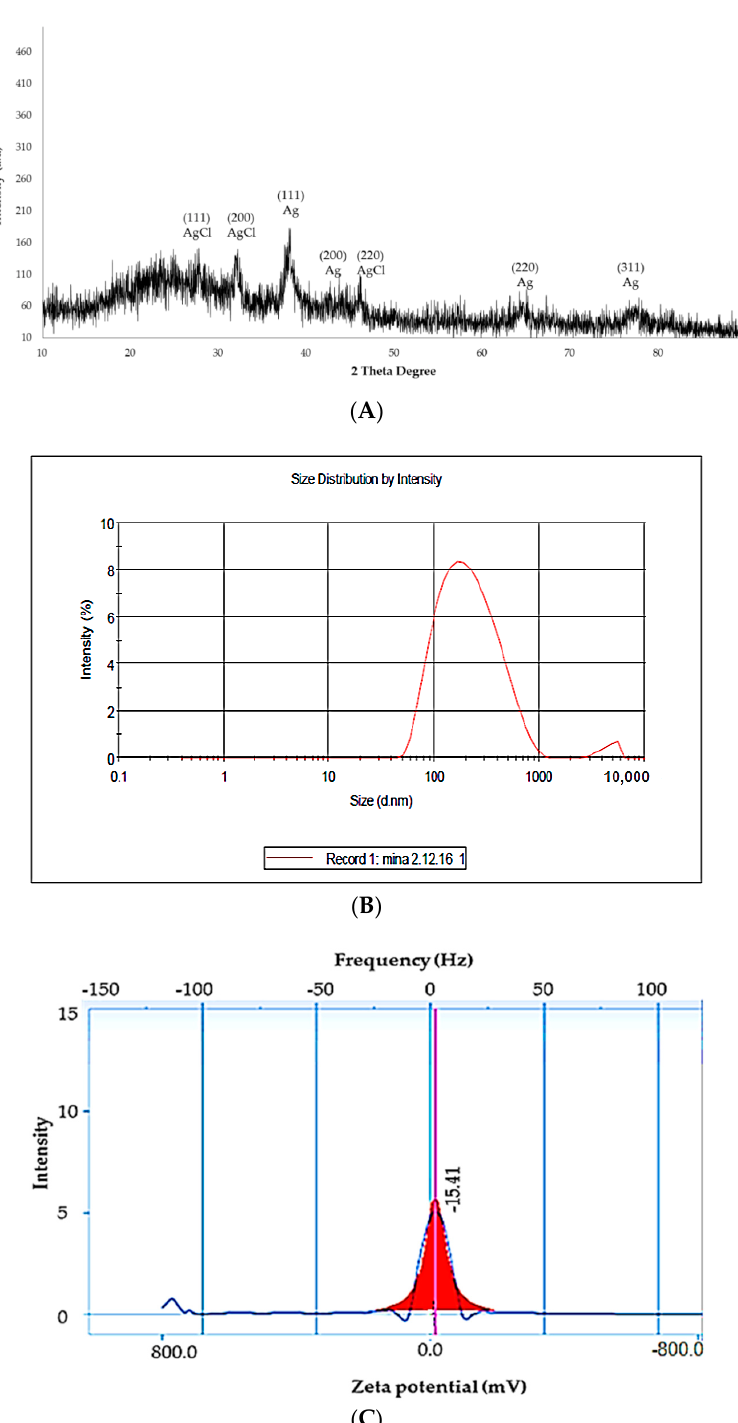
Figure 3. ( A ) XRD pattern of DSAgNPs, ( B ) Size distribution of DSAgNPs obtained from dynamic light scattering, ( C ) Zeta potential of DSAgNPs.